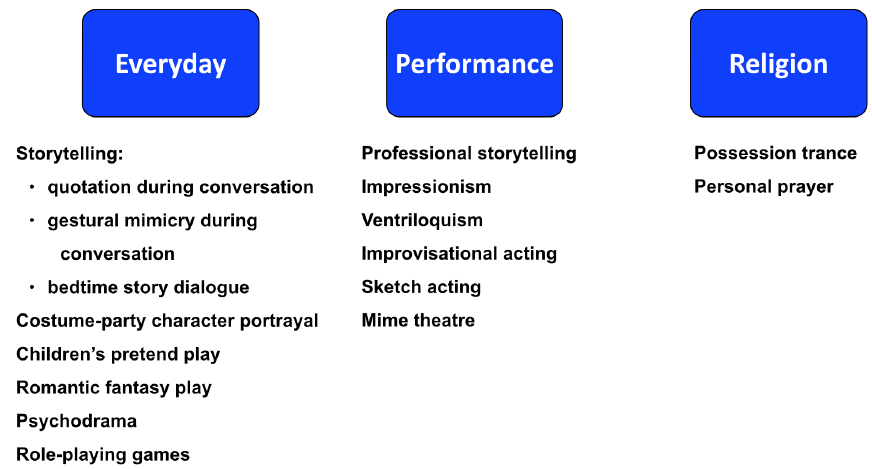
Figure 2. Common forms of proto-acting. The forms are divided into everyday, performance, and religion-related